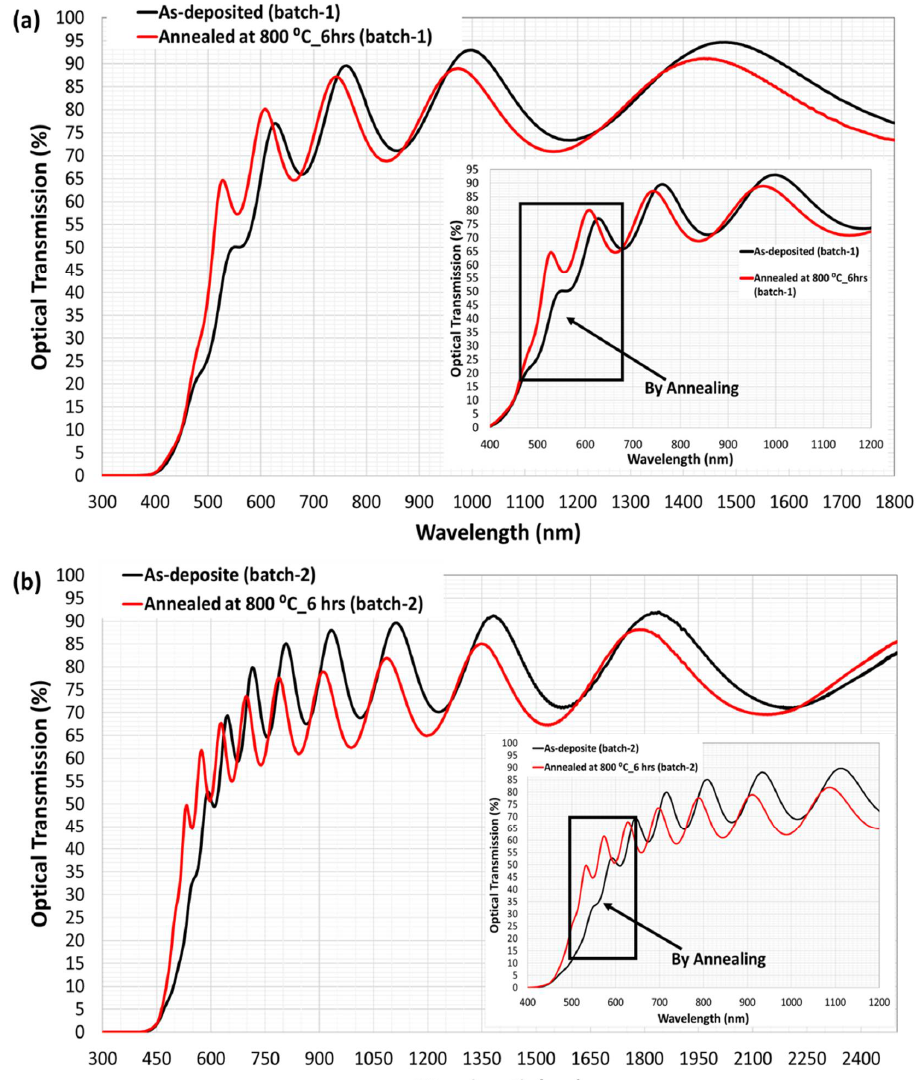
Figure 4. Measured transmission spectra of as-deposited and annealed garnet samples of about